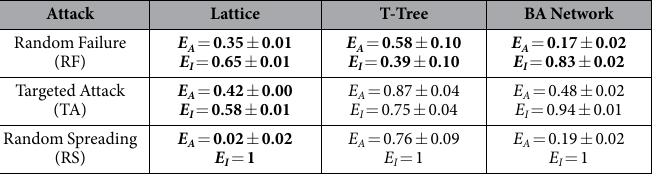
Table 1. Efficiencies for the three attack strategies applied to the Lattice, Tokunaga Tree (T-Tree) and Barabasi Albert (BA) networks.